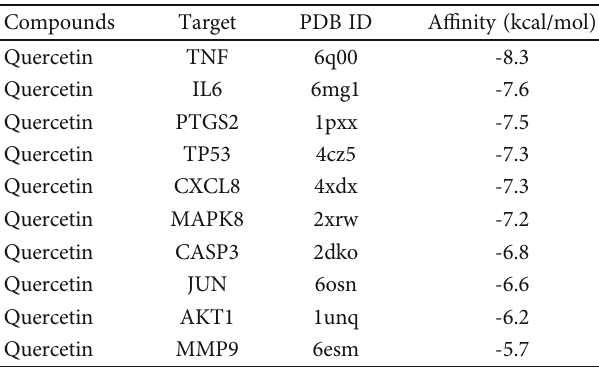
Figure 5: The component-target-pathway network constructed by Cytoscape. The yellow arrows represent active components of AMB, the green nodes represent the targets, and the orange triangles represent signaling pathways. Node sizes are proportional to their degree. Table 4: Molecular docking parameters and results of ten key targets with